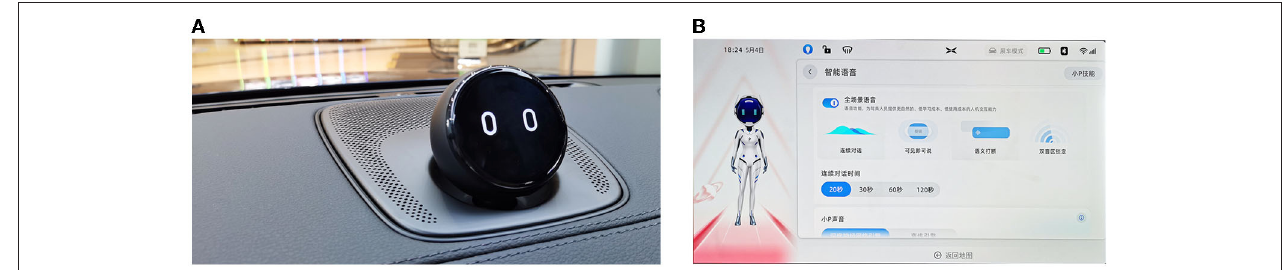
FIGURE 1 | Examples of agents in different forms: (A) NOMI in the physical form; (B) XiaoP in the virtual